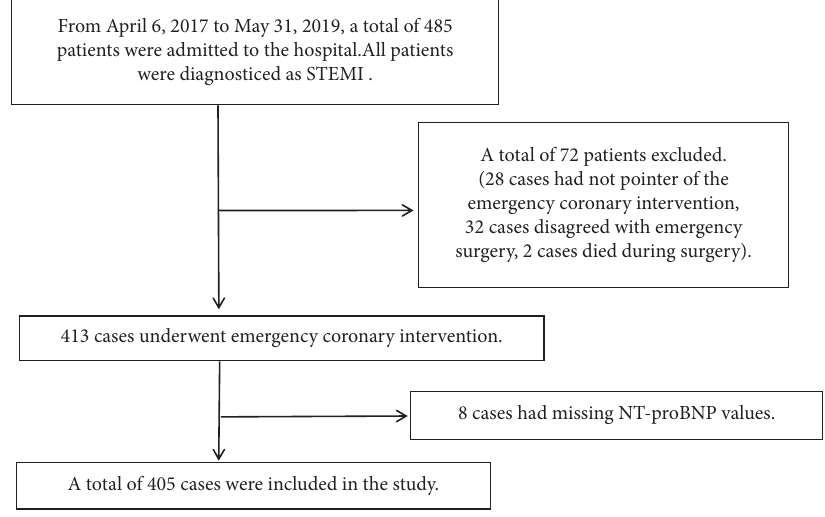
Figure 1: A flowchart on how participants were selected for the final